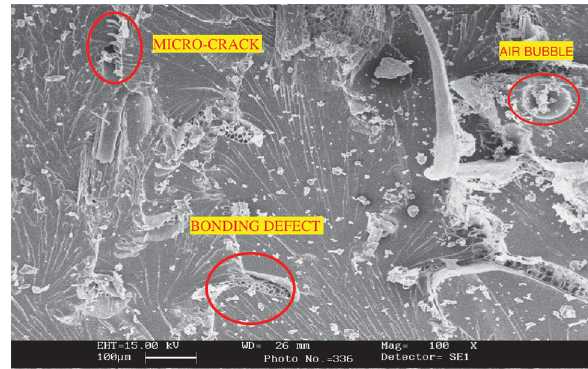
Figure 8: Scanning electron micrograph for 1.5% CR with 5.0% CFF composite.